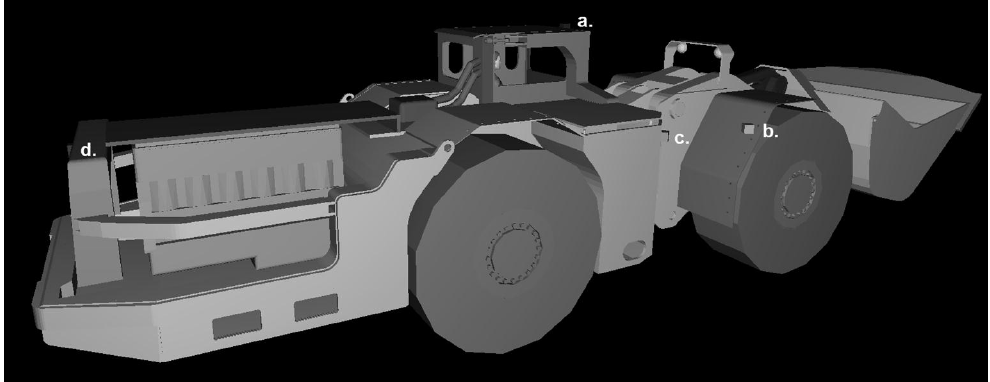
Figure 2. Cameras on the LHD lettered alphabetically clockwise.